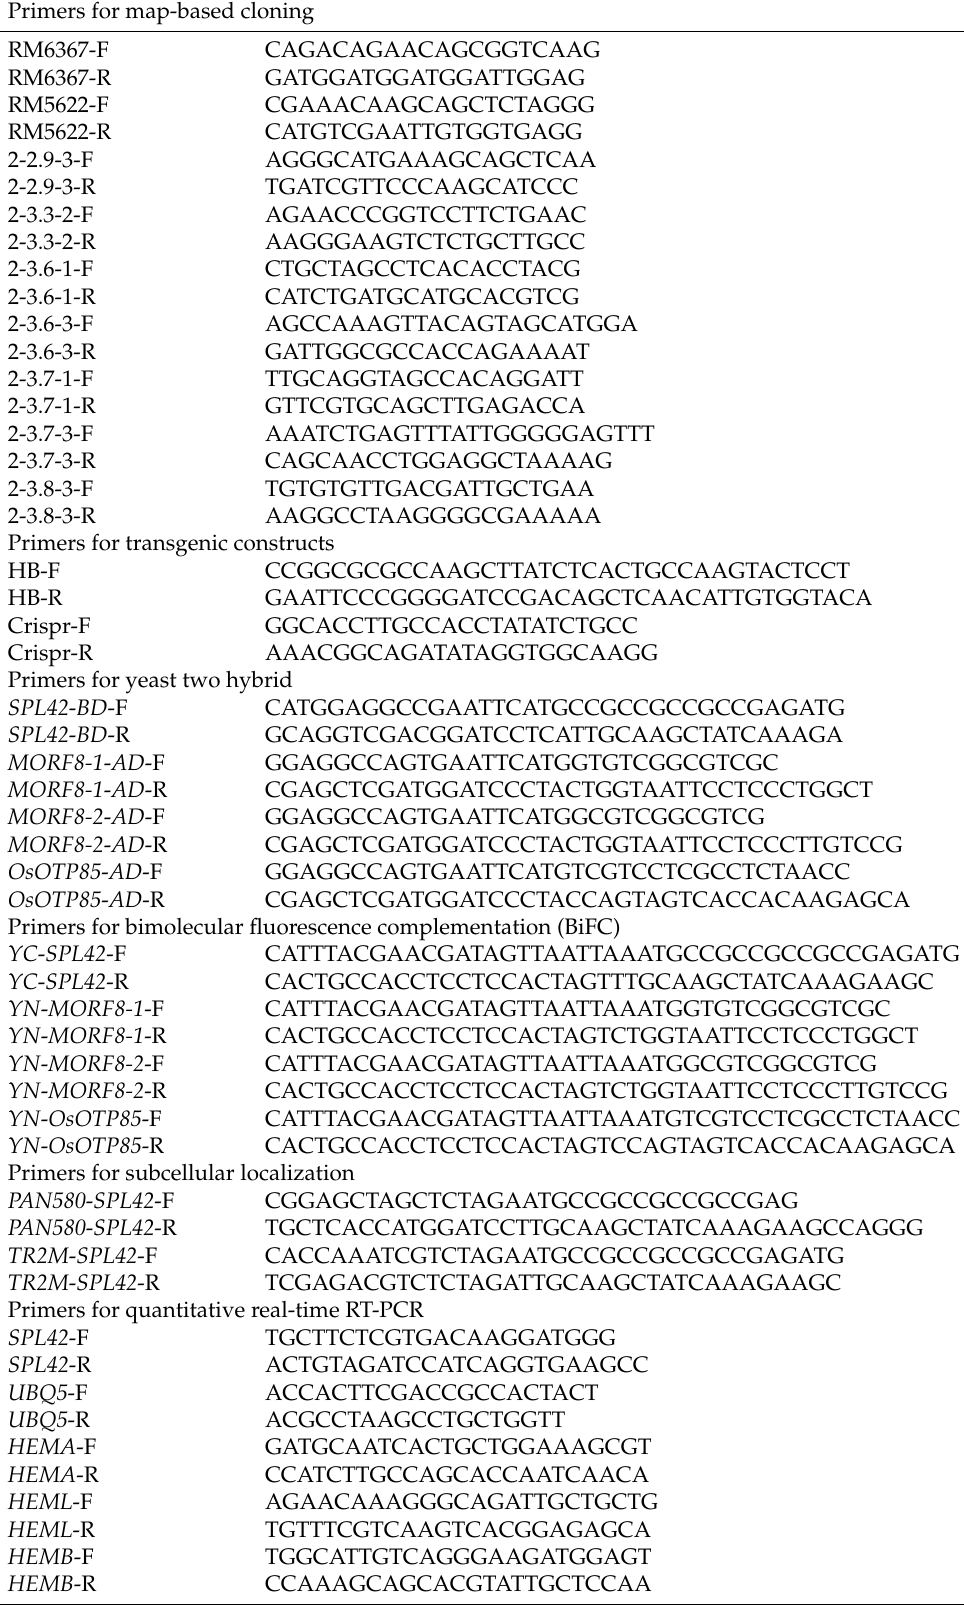
Table A4. List of primer sequences (5 (cid:48) → 3 (cid:48) ) used in this